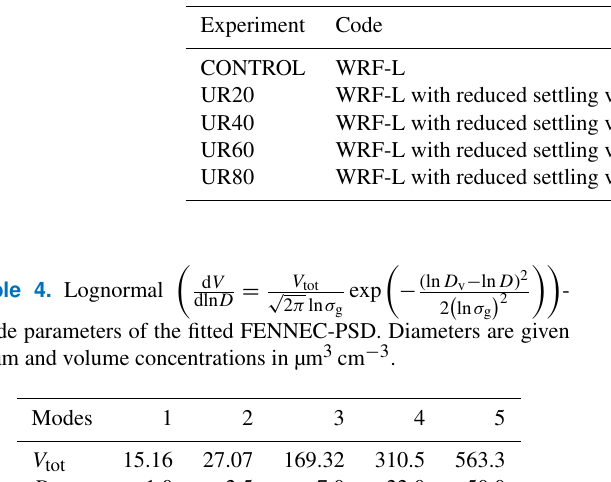
Table 3. Experimental runs that were performed in this study. Experiment Code CONTROL WRF-L UR20 WRF-L with reduced settling velocities by 20% of their settling velocity UR40 WRF-L with reduced settling velocities by 40% of their settling velocity UR60 WRF-L with reduced settling velocities by 60% of their settling velocity UR80 WRF-L with reduced settling velocities by 80% of their settling velocity